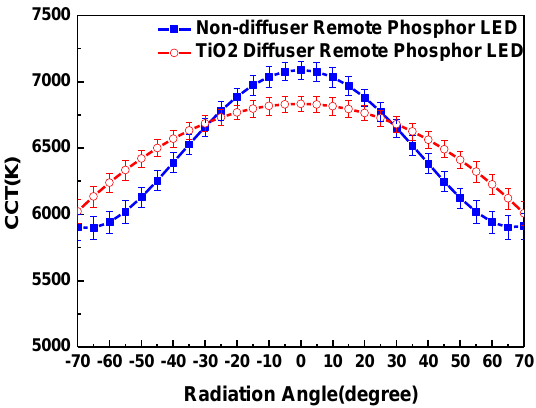
Figure 5. Angular CCT distribution of non-diffuser and TiO 2 diffuser-loaded encapsulation remote phosphor LEDs.